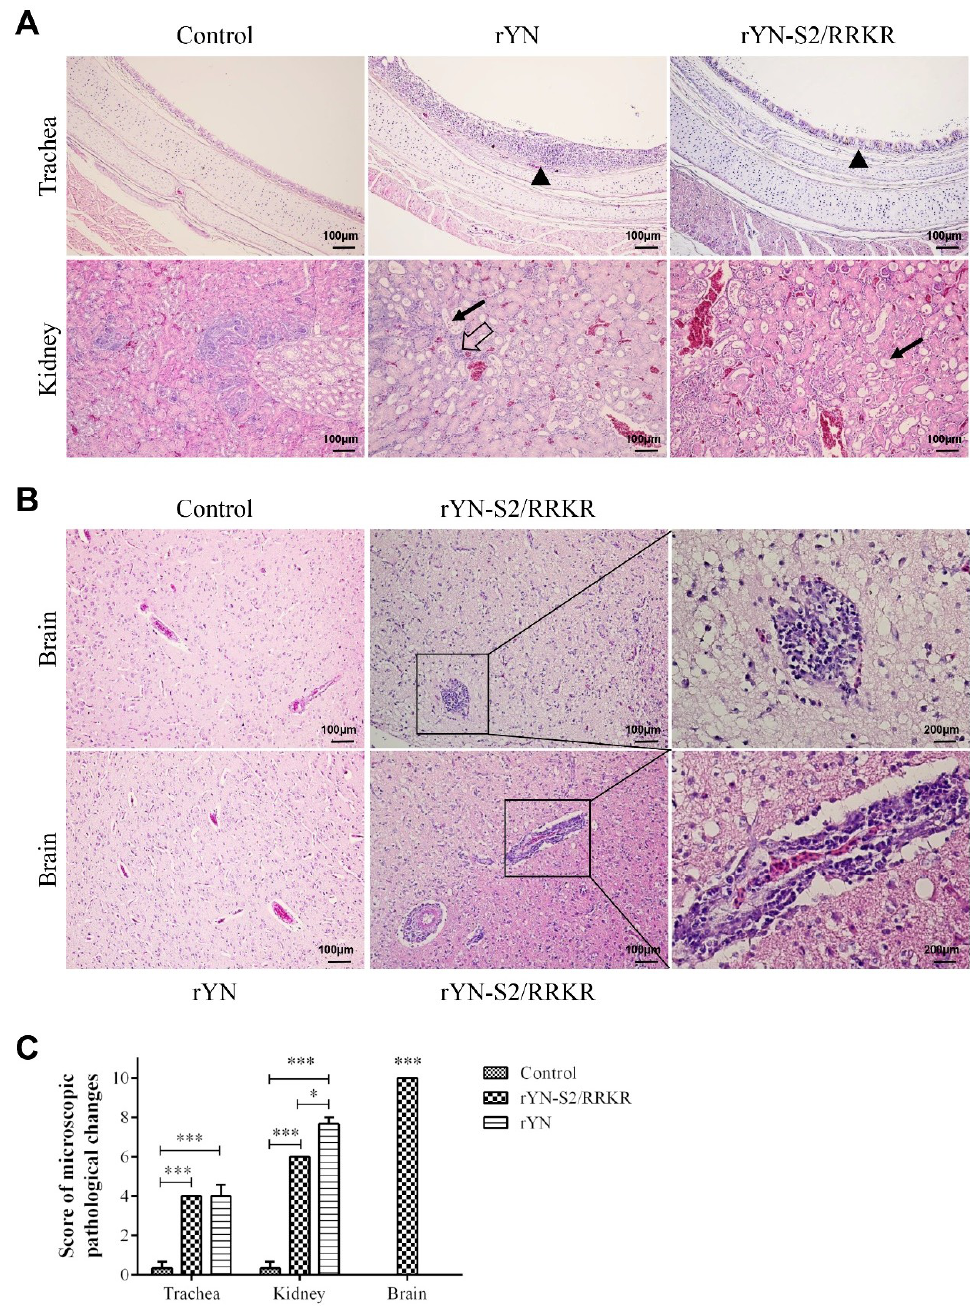
Figure 3. Microscopic lesions were observed in tissues of 1-day-old SPF chicks at 9 dpi. ( A ) Clear lesions could be observed in trachea and kidney in both virus-inoculated groups. The black triangles indicate clear mucosal thickening and infiltration of a large number of inflammatory cells in the trachea. The black arrows indicate cellular cast in the kidney. The blank arrow indicates inflammatory cell infiltration in kidney interstitium. ( B ) Results of H&E-stained brain sections from the rYN-S2 / RRKR group. The panel indicates substantial microglial hyperplasia, forming microglial nodules in the brain (top). The panel indicates the formation of perivascular inflammatory infiltrates (bottom). No obvious lesions were observed in the brain of rYN and control groups (left). ( C ) Scores of 1-day-old chicken group. Sections stained with H&E were evaluated and the scores from 0 to 10, reflecting the severity of the lesions, were recorded. The indications for the scores were as follows: 0 = no microscopic lesions, 1–3 = mild lesions, 4–6 = moderate lesions and 7–10 = severe and extensive lesions. Both rYN and rYN-S2 / RRKR caused serious injury in the respiratory and urinary systems of 1-day-old chicks, while rYN-S2 / RRKR caused serious injury in the CNS ( n =